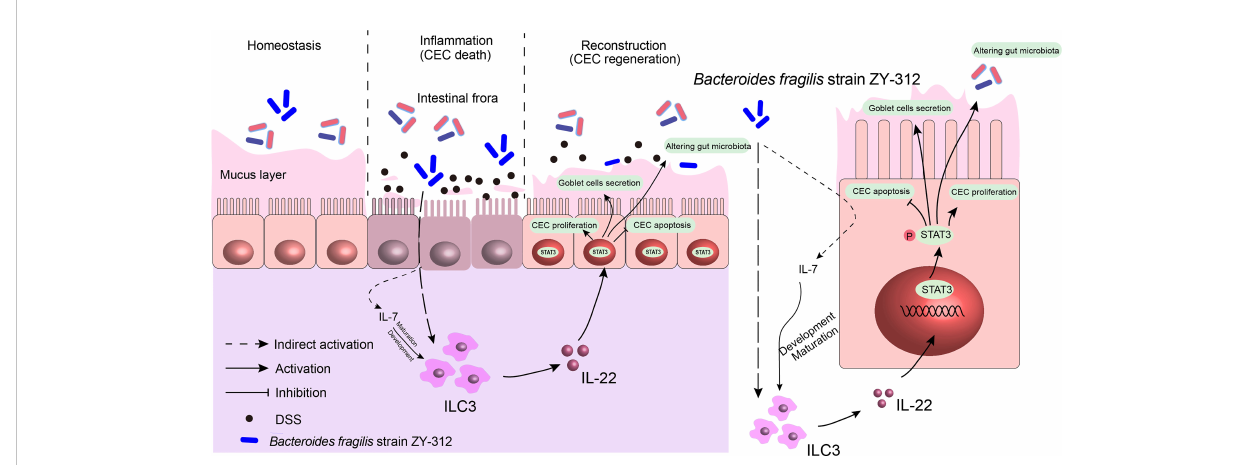
FIGURE 7 B. fragilis facilitates colonic mucosa regeneration in colitis via motivating the STAT3 pathway induced by IL-22 from ILC3 secretion. B. fragilis promoted CLP-derived ILC3 to secrete IL-22, then motivated the STAT3 signaling pathway, hence promoting colonic mucosa proliferation and mucus secretion, inhibiting apoptosis, and altering gut microbiota in DSS-induced